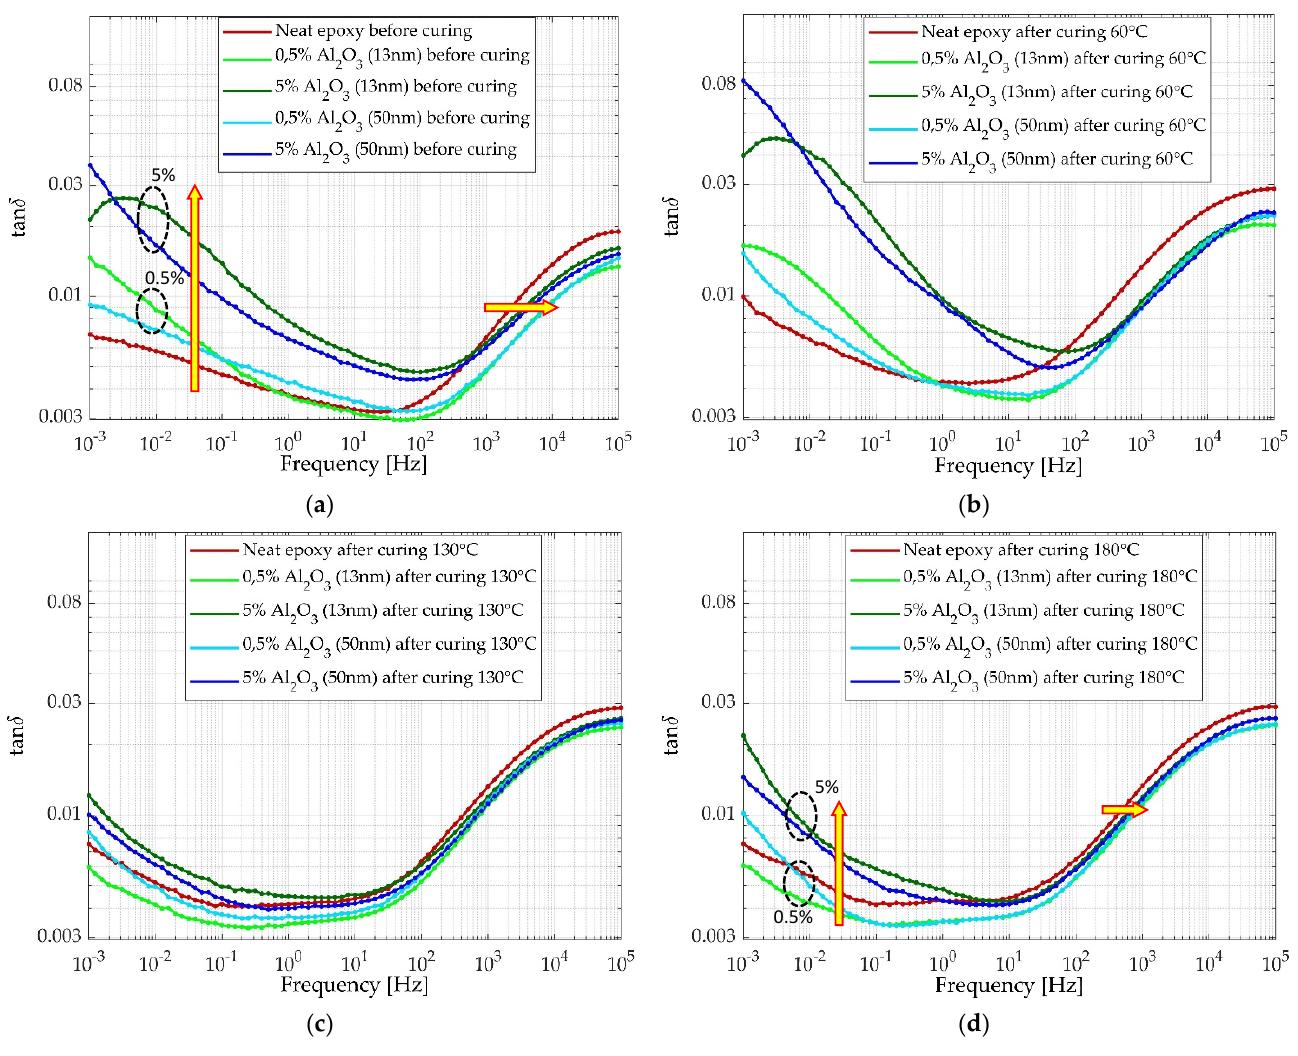
Figure 12. Selected curing temperature-dependent broadband characteristics of the dielectric losses for Al 2 O 3 nanoparticles with an average size of 13 nm and <50 nm, for two limit values of wt% used during the tests, 0.5% and 5.0%: ( a ) new, before curing, ( b ) after thermal curing at 60 °C, ( c ) after thermal curing at 130 °C, ( d ) after thermal curing at 180 °C.